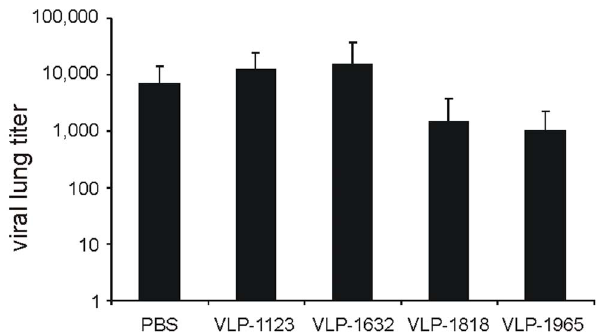
Figure 6. Immunization with M2e-VLPs reduces lung virus replication. BALB/c mice were immunized twice two weeks apart with 10 m g of Alhydrogel-adjuvanted PBS, VLP-1123, VLP-1632, VLP-1818 or VLP-1965. Two weeks after the boost, mice were challenged with 4 LD 50 of X47 virus. Six days after challenge, four (PBS) or five (all other groups) mice from each group were sacrificed to determine lung virus titers. Virus titers are expressed as mean log 10 TCID 50 /ml and error bars depict the standard error of the mean.